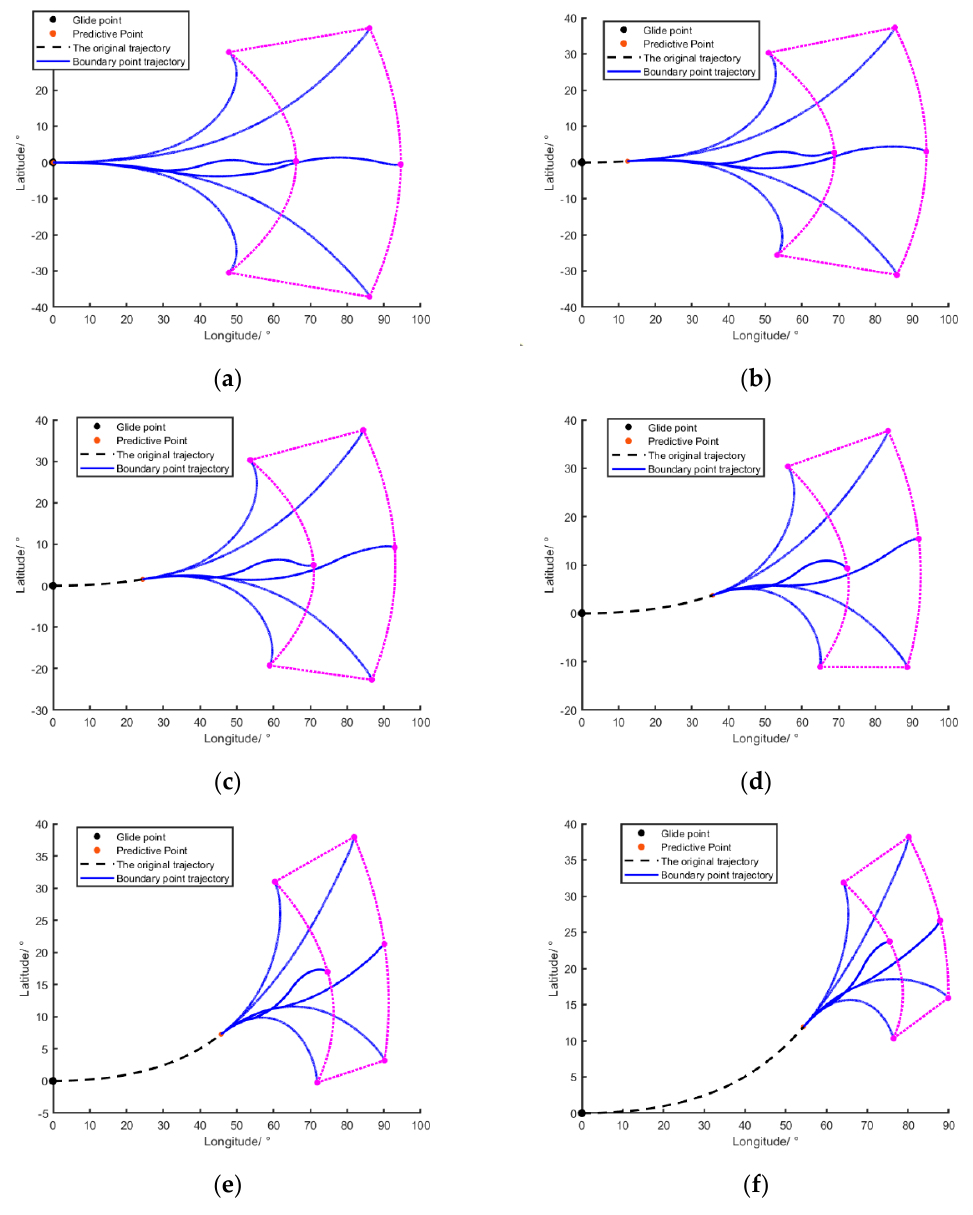
Figure 6. The history of the reachable zone: ( a ) is t p = 0 s; ( b ) is t p = 200 s; ( c ) is t p = 400 s; ( d ) is t p = 600 s; ( e ) is t p = 800 s; ( f ) is t p = 1000 s.